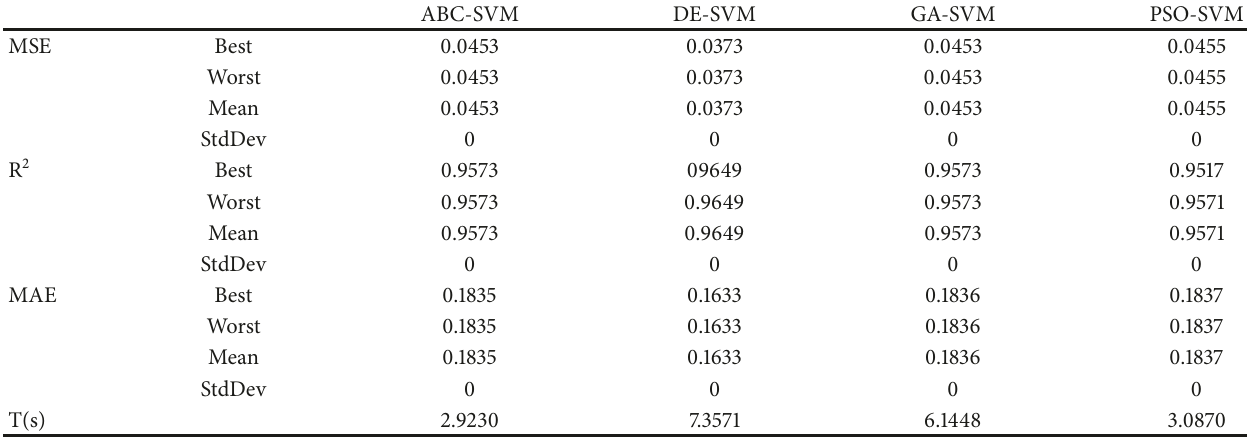
Table 4: Statistical results of 30 runs obtained by ABC-SVM, DE-SVM, GA-SVM, and PSO-SVM models for AISI 1045 steel.